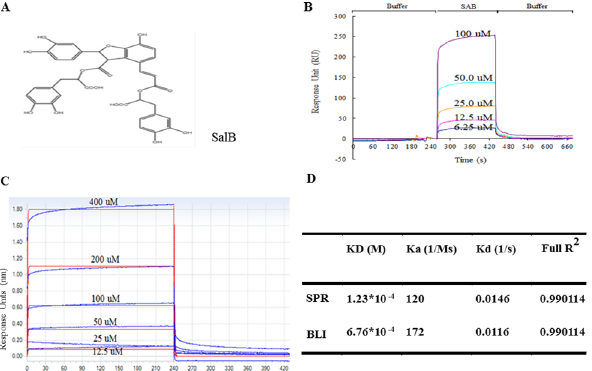
Fig 7. A: The chemical structure of SalB and the kinetic binding of SalB to Src. B : Binding assay by SPR. C : Binding assay by BLI. Binding assays were performed using a series of 2-fold diluted human Src solution. Association time was set at 10 min and dissociation time was set at 30 min. Affinities were derived by fitting the kinetic data to a 1:1 Langmuir binding model utilizing global fitting algorithms for determination of the association rate (K a ), dissociation rate (K d ), and affinity (K D ) of biomolecule interactions. D: K a , K d and K D values derived from SPR and BLI. Data were expressed as mean ± SE of 6 independent